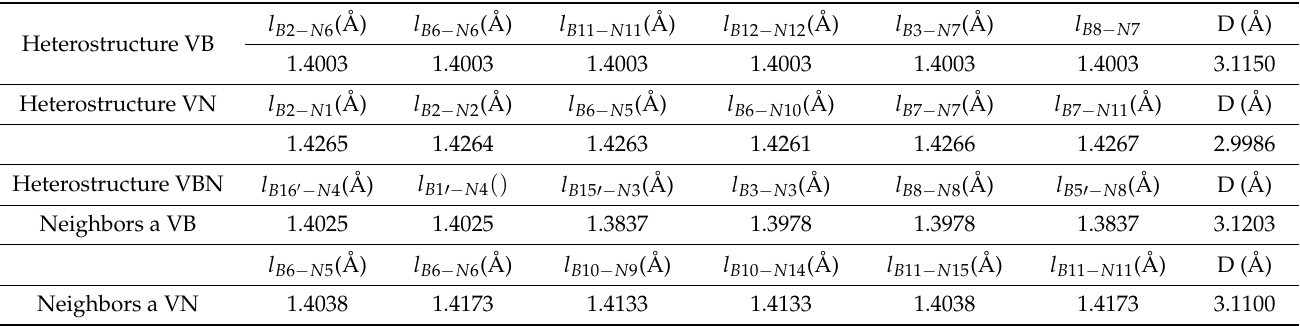
Table 2. Principal structural parameters measured in Å: BN bond lengths ( l Ni − Bj ) and interfacial distances (D). The labels i and j correspond to the neighbor atoms of the vacancies. The prime superscripts ( (cid:48) ) correspond to the images of the